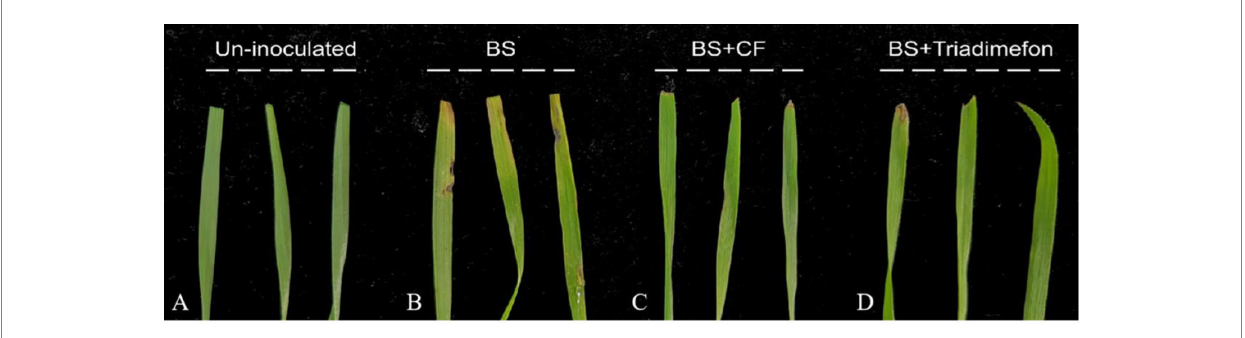
FIGURE 8 Control effect of DB2 on spot blotch in a detached leaf assay. (A) Sterile water treatment (Un-inoculated). (B) Only Bipolaris sorokiniana (BS) inoculation without cell-free culture filtrate ( CF ) treatment. (C) BS + cell-free culture filtrate treatment. (D) BS + Triadimefon treatment.